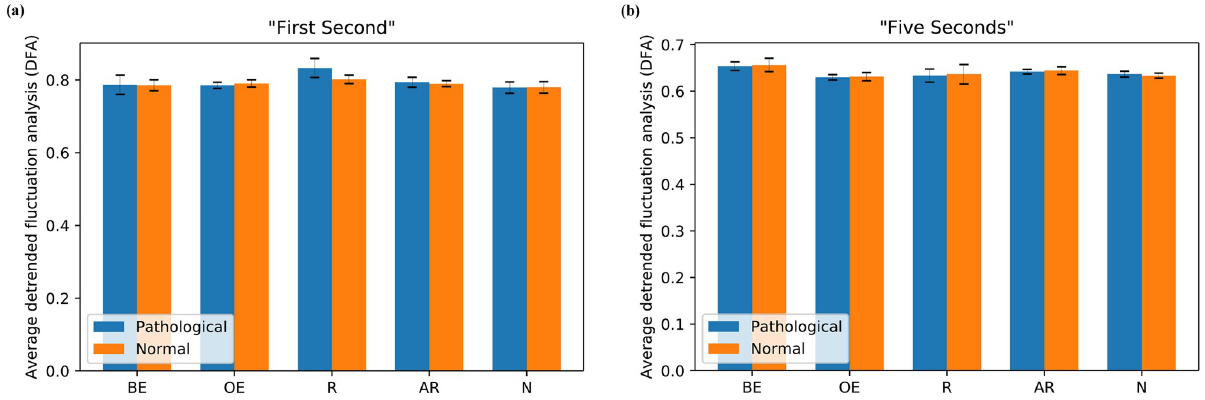
Fig 8. Average detrended fluctuation analysis (DFA) exponent of scanpaths for pathological and normal stimuli across different groups of participants: Brain-experts (BE), Other-experts (OE), Registrars (R), All-radiologists (AR), and Na ï ves (N) (a) “First Second” and (b) “Five